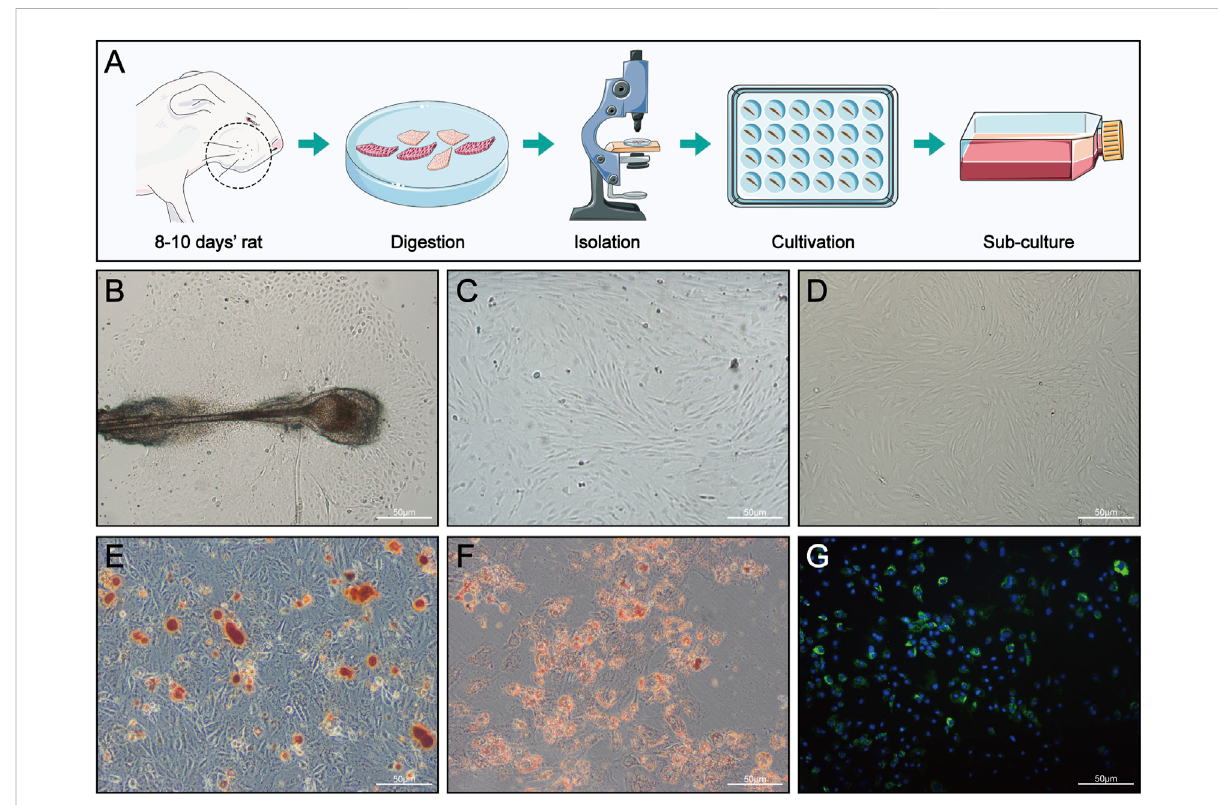
FIGURE 3 HFMSC isolation, culture, differentiation and staining. (A) Isolation and culture of HFMSCs. (B) Primary HFMSCs clustered around the dermal sheath and dermal papilla. (C) Primary cells cultured for approximately 10 days (D) First-passage of HFMSCs showed the classic fi broblast-like and adherentgrowthpatternsofMSCs. (E,F) Osteogenic (E) andadipogenic (F) differentiationofHFMSCs. (G) ThenucleiofHFMSCswerestainedblueby DAPI, and the cell membrane was stained green by